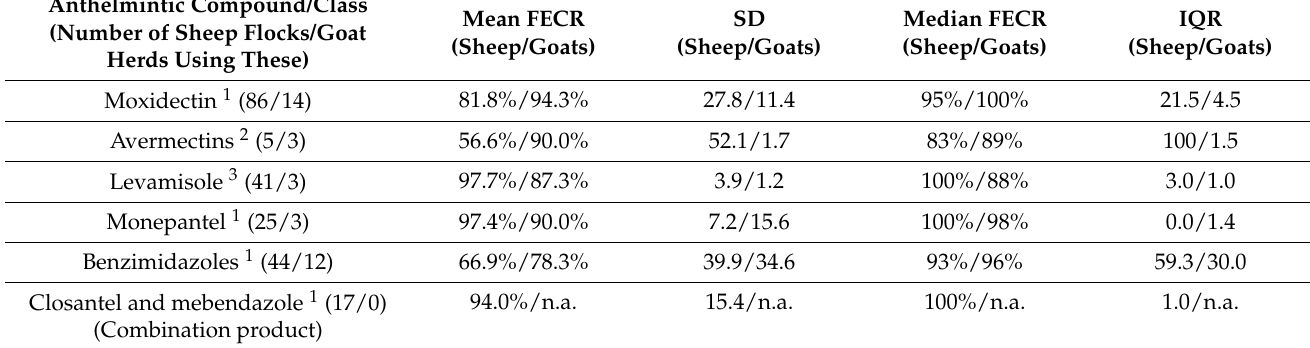
Table 4. Descriptive statistics of faecal egg count reduction (FECR) for all treatments (both small ruminant species, and including successful and unsuccessful treatments), by anthelmintic cate- gory. Treatments chosen and performed by farmers and their veterinarians. Pooled samples were used, and the samples originated from 223 small ruminant flocks, which performed 253